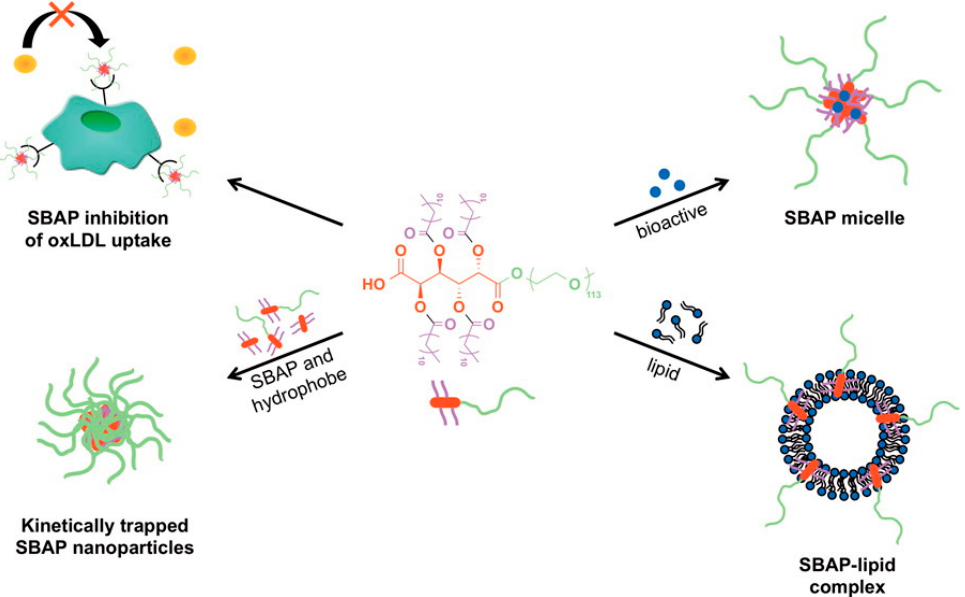
Figure 4. Sugar-based amphiphilic polymers (SBAPs) for biomedical applications [51]. oxLDL = oxidized low-density lipoproteins.